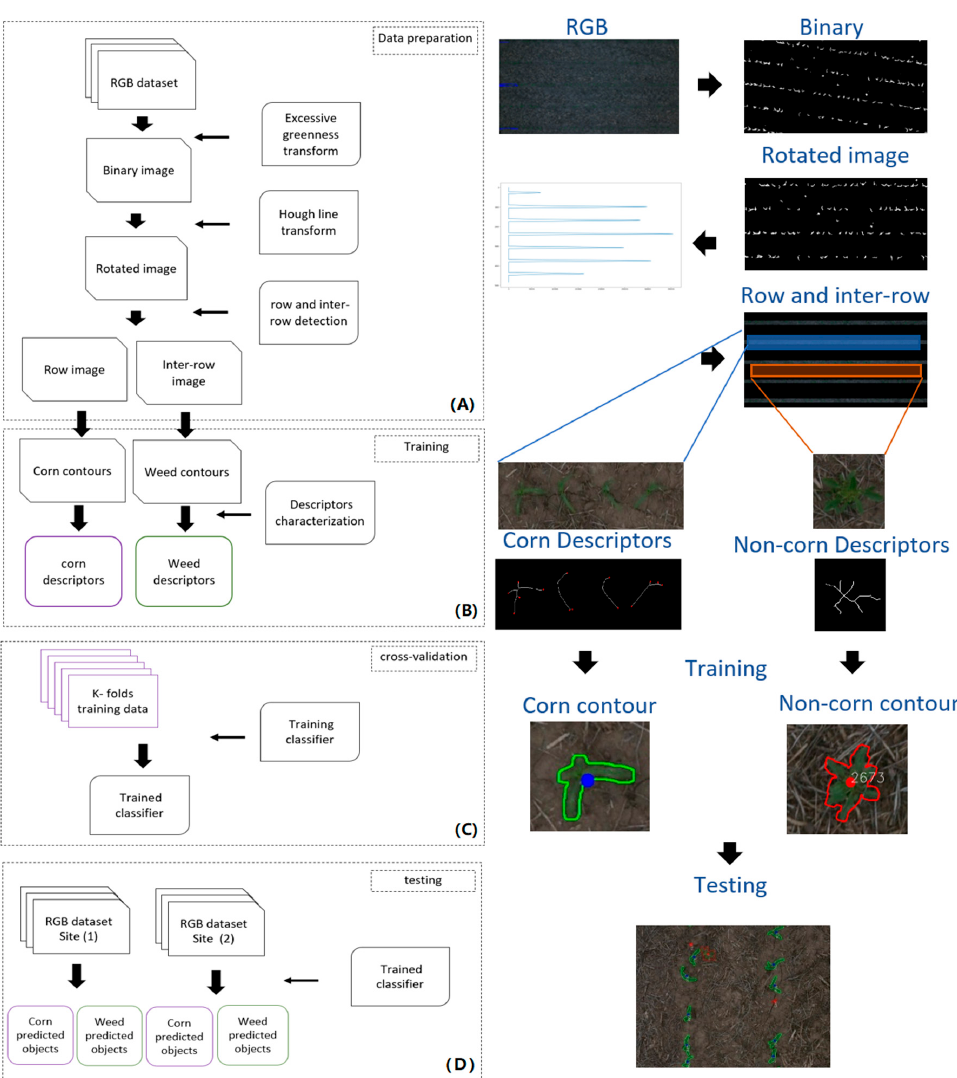
Figure 2. Workflow for plant estimation via unmanned aerial systems (UAS). ( A ) data pre-processing, ( B ) training, ( C ) cross-validation, and ( D ) testing.